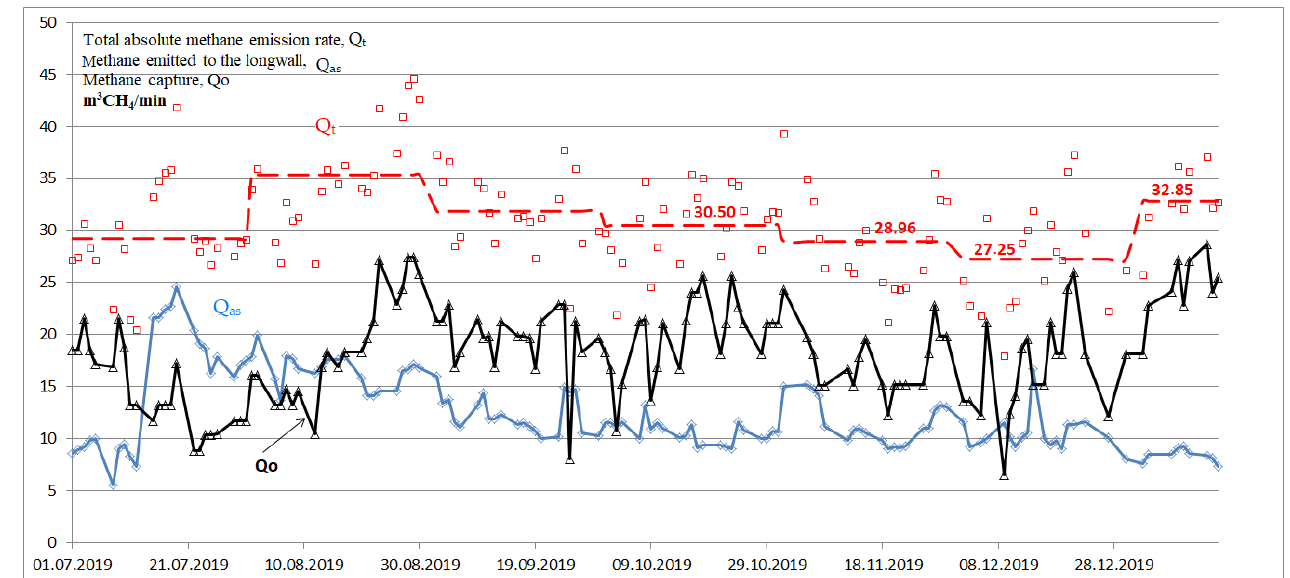
Figure 9. Courses of the methane capture (Q o ) from the longwall to the drainage network, the absolute methane emission rate (total, Q t ) and the methane emitted to the K-2 longwall area (adjacent strata, Q as ).